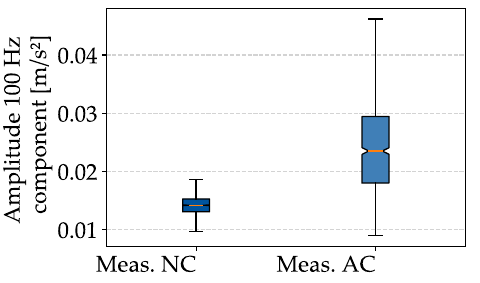
Figure 11. Box plots of the normal- and fault-condition measurements.